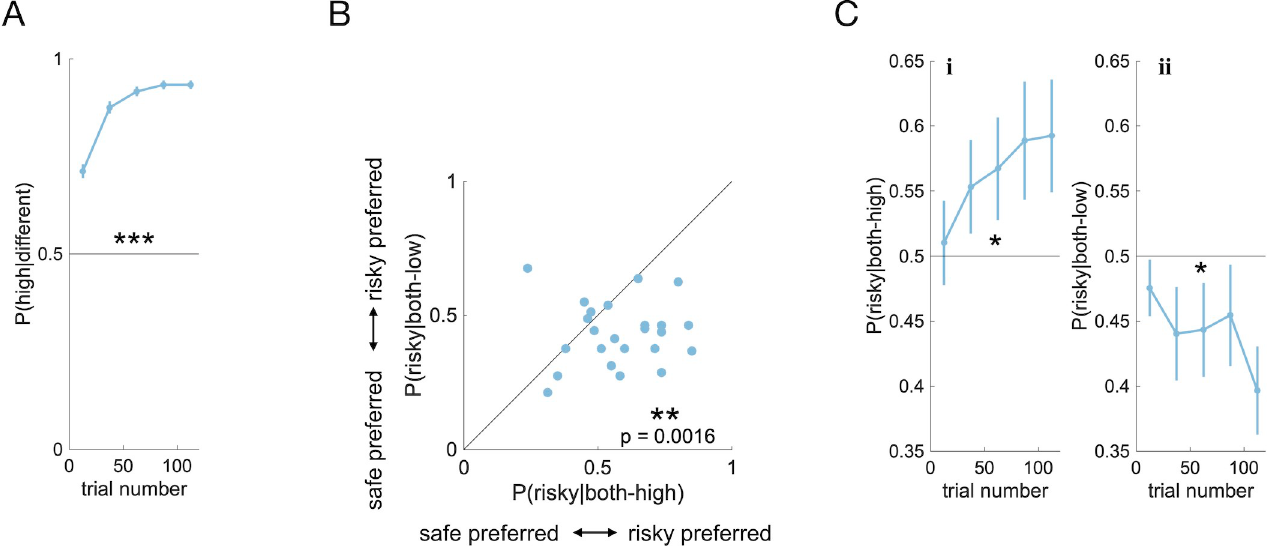
Fig 2. Condition-specific risk preferences emerge gradually. A) Probability of choosing a stimulus with high average reward over a stimulus with low average reward, as a function of trial number. Choices were binned according to trial number. For each bin, we show the mean (dot) and SE (bar) over subject means. The stars ( � : p < 0.05, �� : p < 0.01, ��� : p < 0.001) indicate that the population mean across all trials is significantly different from indifference (0.5). B) Correlation between risk preferences in the both-high mean and the both-low condition across all trials. Each point represents one participant. Preference for the risky stimulus if mean rewards are high is plotted against preference for the risky stimulus if mean rewards are low. If a point falls below the diagonal, the participant was more risk-seeking for high-mean stimuli than for low-mean stimuli. The stars indicate that the population mean is significantly below the diagonal. C) Probability of choosing the risky stimulus over the safe stimulus, i) if mean rewards are both high, ii) if mean rewards are both low, as a function of trial number. Data represented as in A. Data and code to reproduce this figure can be found at